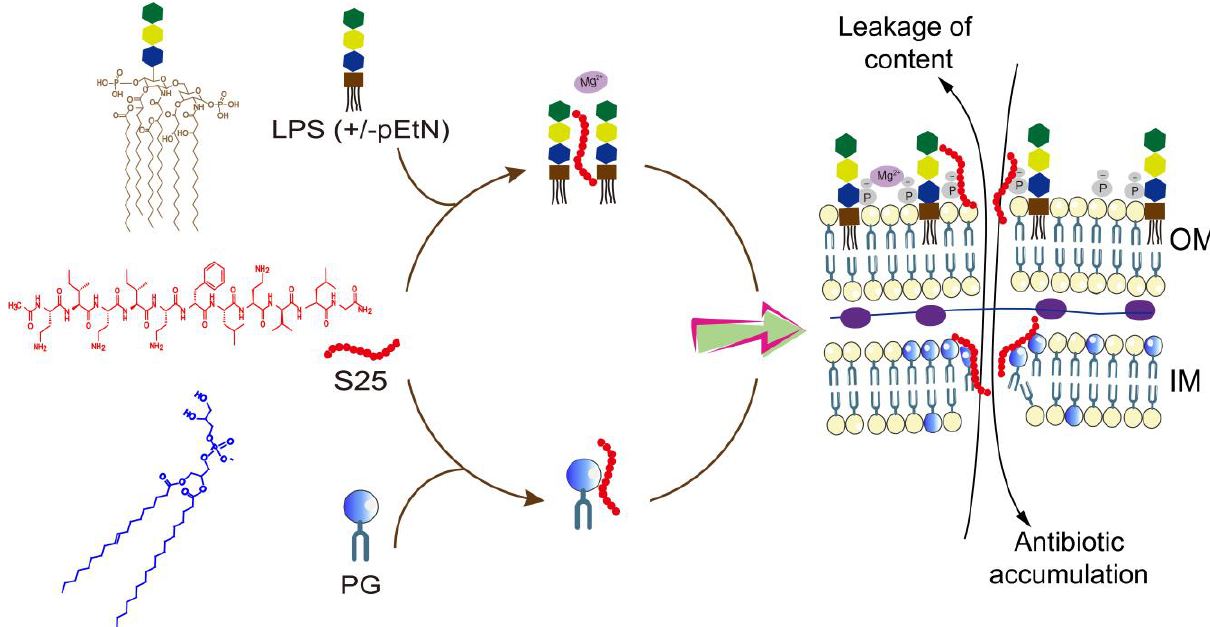
FIGURE 1: Mechanism of the synergy of SLAP-S25 in combination with antibiotics. SLAP-S25 targets both LPS and pEtN-LPS by competing with Mg 2+ to dissect the tight joint between two neighboring lipids of LPS to increase the permeability of the outer membrane. pEtN-LPS is a modified LPS molecule. Importantly, SLAPS25 binds to the terminal group in the glycerol of PG, disrupting the integrity and function of the inner membrane. The collective behaviors of SLAP-S25 finally result in the intracellular accumulation of antibiotics to potentiate antibiotic